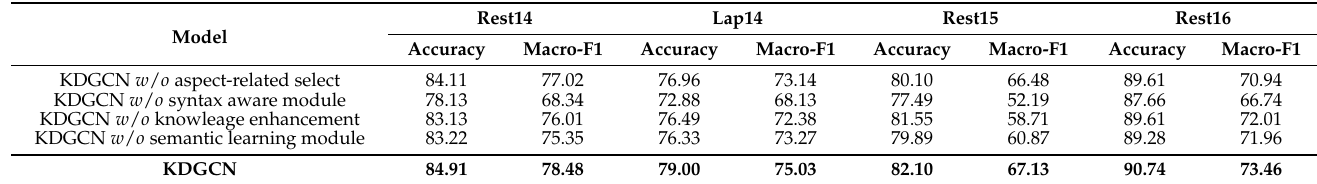
Table 3. Results of the ablation